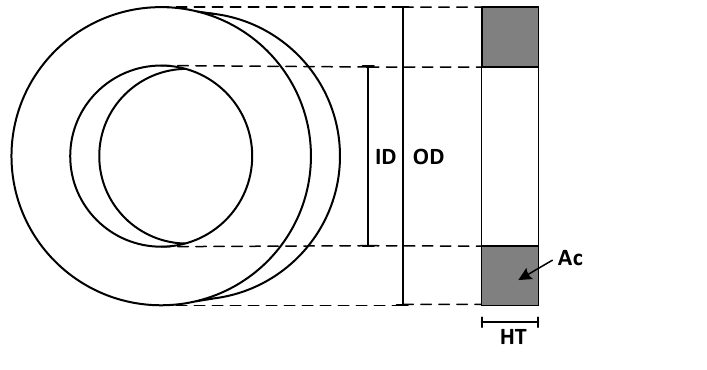
Figure 1. MFT Design methodology.